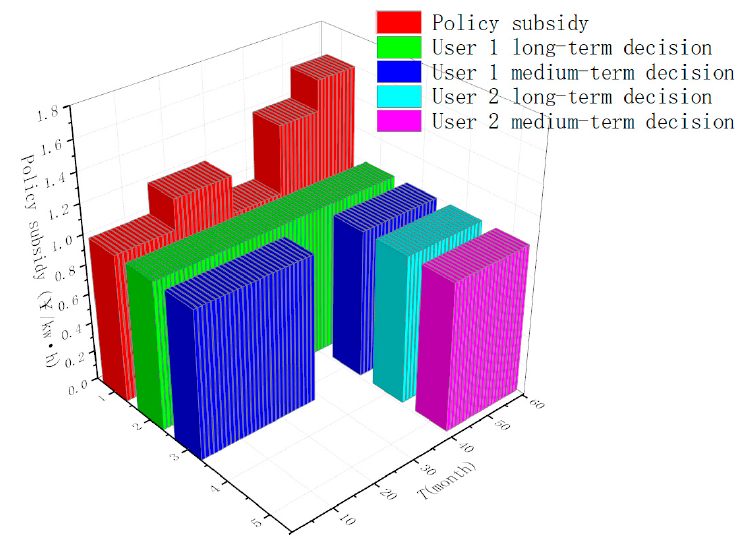
Figure 17. Medium- and long-term decision-making of electric vehicle.